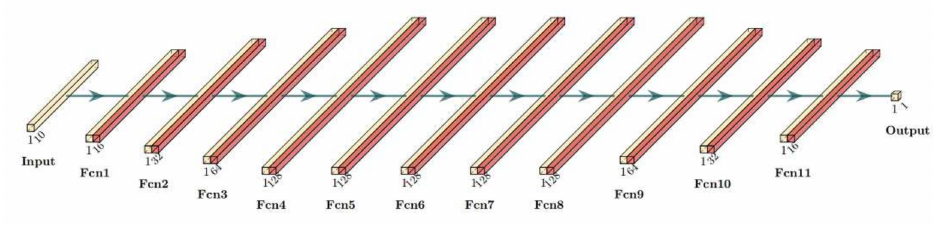
Figure 5. Eleven layers of DNN. Fcn represents the full connection layer; each full connection layer also connects to a ReLu layer.